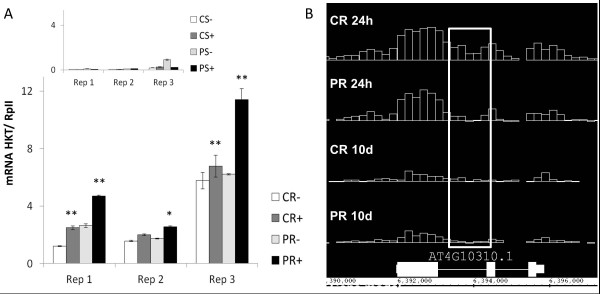
Transcript and H3K27me3 profiles of HKT1 in primed and non-primed plants. (A) mRNA levels of HKT1 (relative to constitutive gene RpII) determined by qPCR in roots of primed plants (PR, light grey and black bars) or non-primed plants (CR, white and dark grey bars) 10 days after priming and 4 h after application of 0 (-, control) or 80 mM NaCl (+, stress treatment). Inset shows very low expression of HKT1 in the shoots of the same plants. Results are shown separately for three independently primed and treated plant batches (Rep1-3) each consisting of pooled tissue from 12 plants. Bars are means ± SE of four pairwise ratios of two technical replicates. Significant differences between primed and non-primed plants for each condition (+/- salt) are indicated with * for P <0.05 or ** for P <0.01. (B) H3K27me3 profile over the HKT1 sequence in primed (PR) and non-primed (CR) root immediately after priming (24h) and 10 days later (10d) as displayed in IGB. The differential site identified by CHIPDIFF in the 24-h samples is marked with a white box.